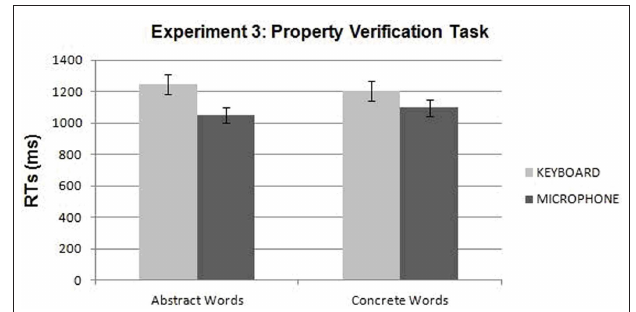
Figure 4 | experiment 3: interaction between Word (Abstract, Concrete) and response device (Keyboard,